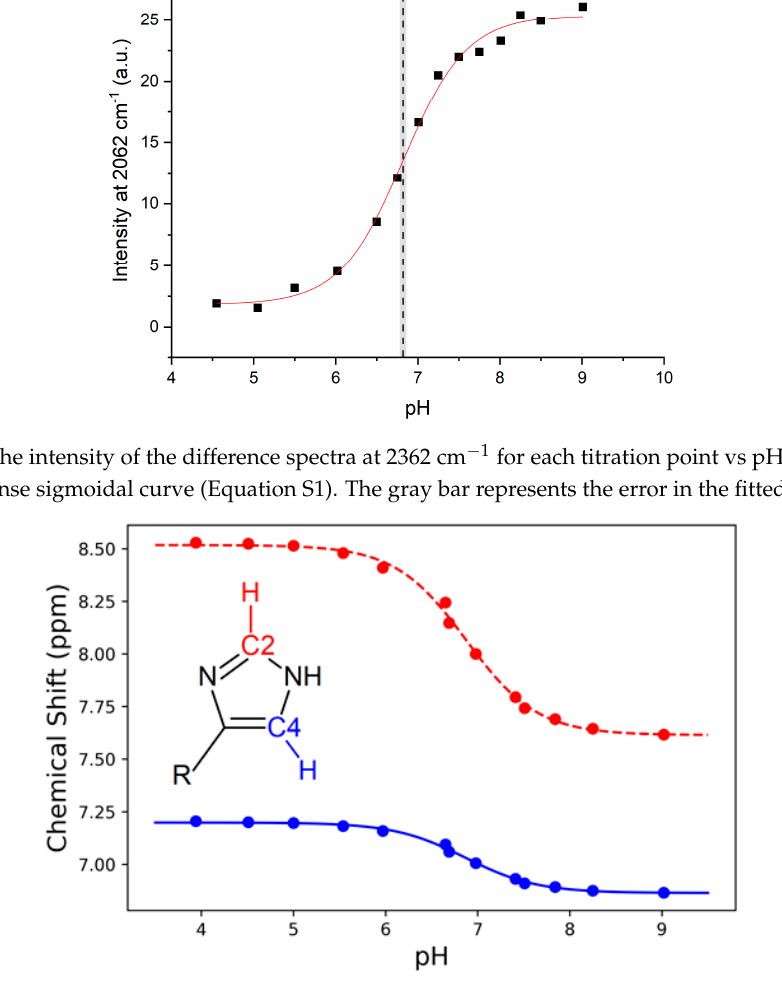
Figure 5. The intensity of the difference spectra at 2362 cm − 1 for each titration point vs pH, fitted to a